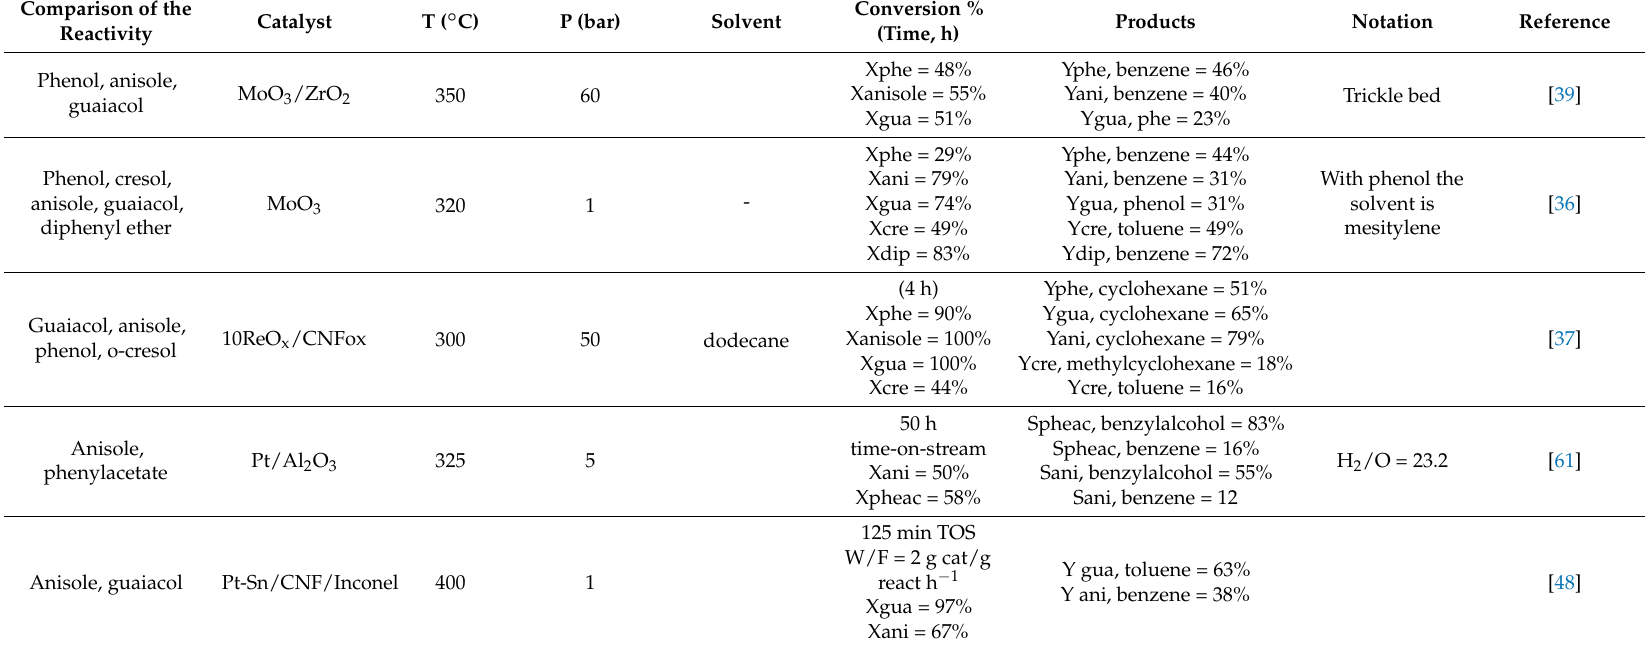
Table 2. Comparative single feed HDO results using one catalyst. Notation: Yi, j is yield in which i is the reactant and j product, X denotes conversion and S selectivity. Comparison of the